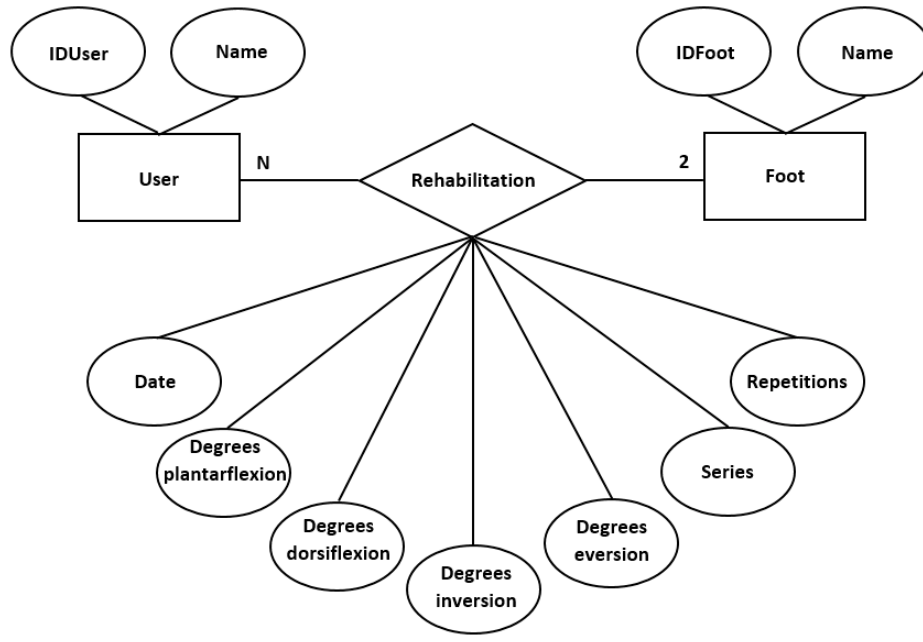
Figure 6. Entity relationship model.